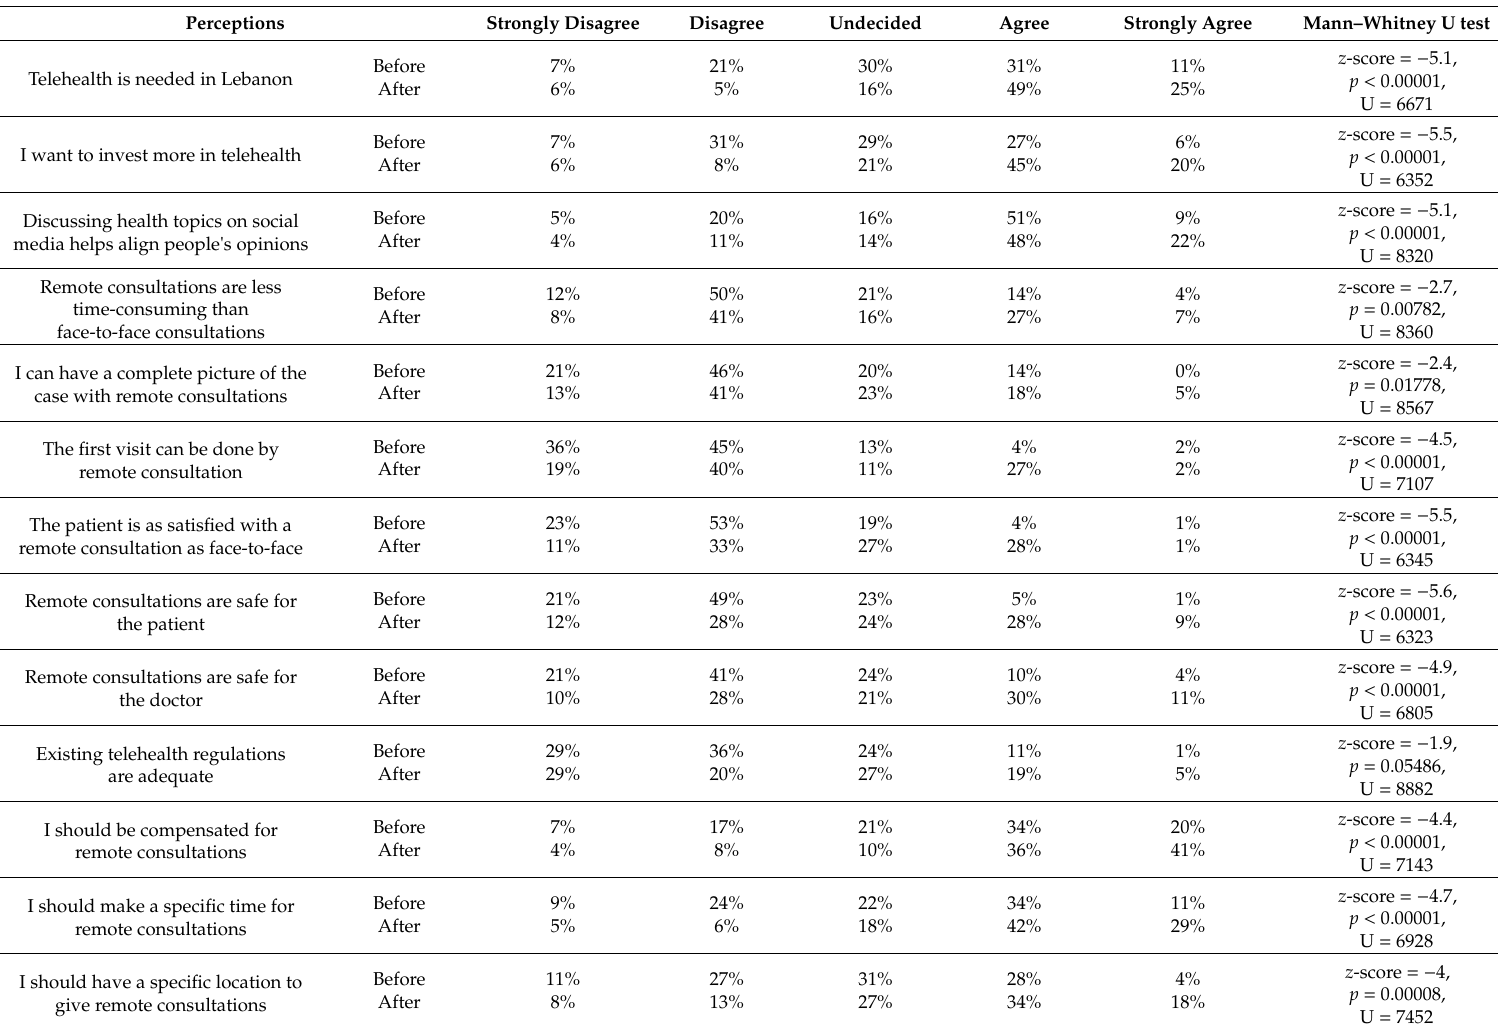
Table 3. Physicians’ perceptions of telehealth before and after their experience of the COVID-19 pandemic. Perceptions Strongly Disagree Disagree Undecided Agree Strongly Agree Mann–Whitney U test Before